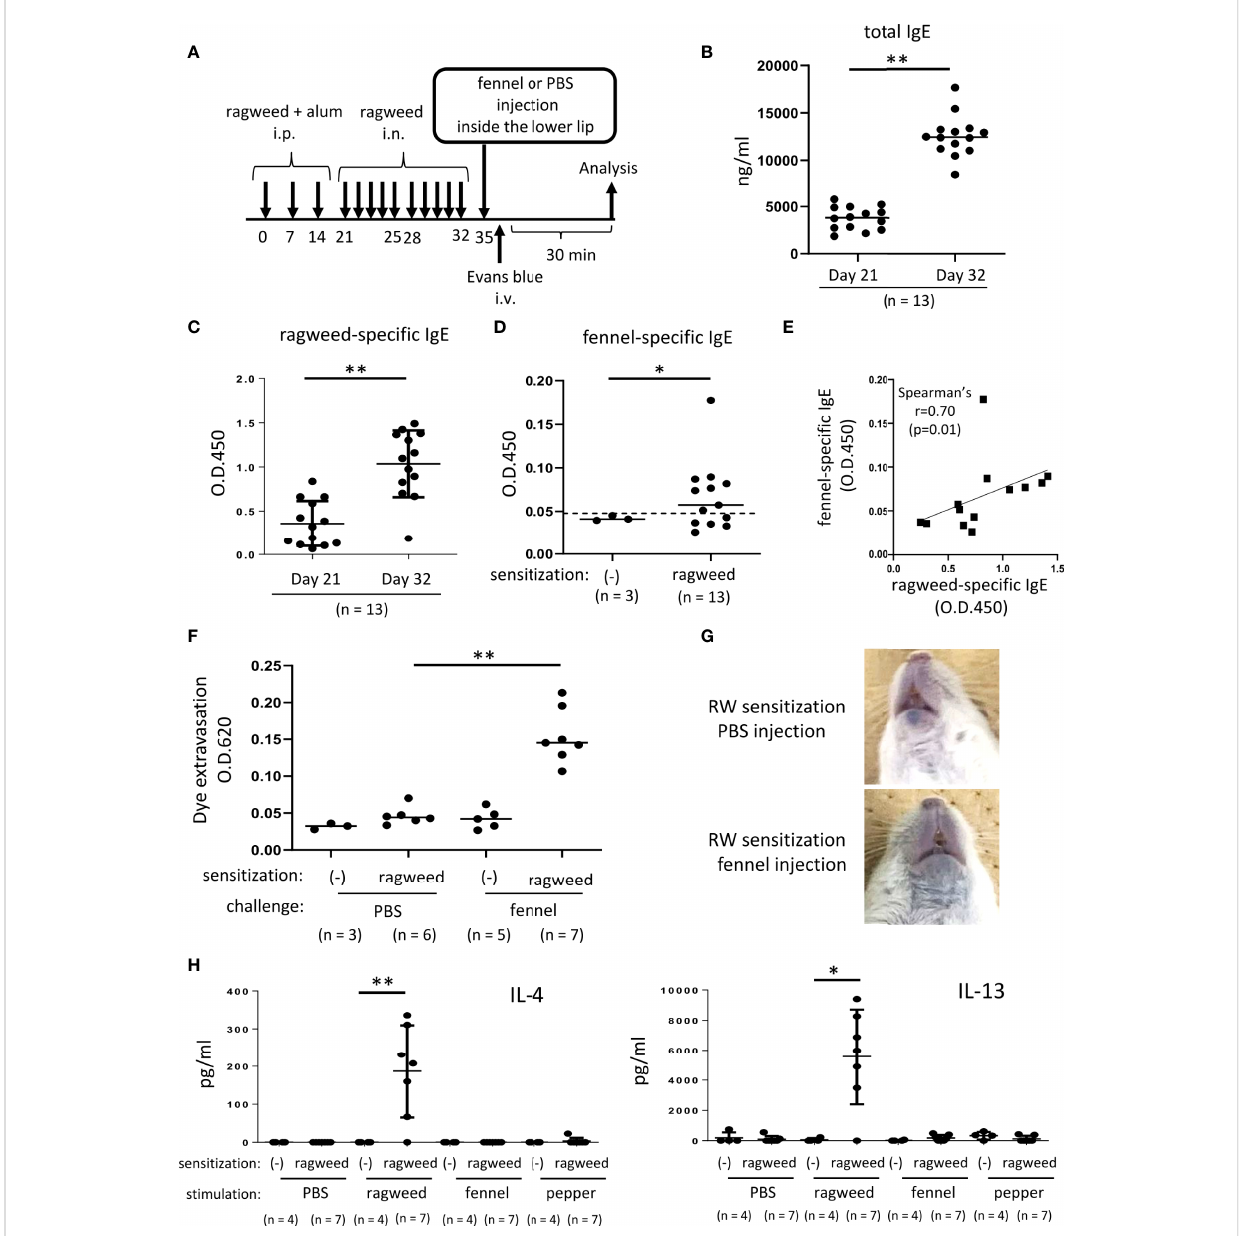
FIGURE 6 Stimulation with fennel extracts induced mast cell-dependent OAS in mice intraperitoneally and intranasally sensitized with ragweed pollen. (A) A schematic representation of murine model of OAS. WT mice intraperitoneally and intranasally sensitized with ragweed pollen before stimulation with fennel or PBS as a control. (B-D) Serum levels of total IgE (B) and ragweed-speci fi c IgE (C) from ragweed-sensitized mice (n = 13) at day 21 and at day 32. (D) Serum levels of fennel-speci fi c IgE from ragweed-sensitized mice (n = 13) at day 32 or from non-sensitized control mice (n = 3). A positivity threshold (mean + 2SD in non-sensitized mice) is shown as a dotted line. Data are expressed as mean ± SD. Data are representative of two independent experiments. Welch ’ s t -test. * P < 0.05; ** P < 0.01. (E) A weak positive correlation between serum levels of ragweed-speci fi c IgE and fennel-speci fi c IgE from ragweed-sensitized mice (n = 13). Spearman ’ s correlation test. (F) Quanti fi cation of the Evans blue dye that extravasated into the neck skin from ragweed-sensitized mice stimulated by fennel extract (n = 7) or PBS (n = 6) or from non-sensitized control mice stimulated by fennel extract (n = 5) or PBS (n = 3). Data are expressed as mean ± SD. Data are representative of two independent experiments. Brown-Forsythe and Welch ANOVA with Dunnett T3 multiple comparisons. ** P < 0.01. (G) Representative pictures of the neck skin from ragweed-sensitized mice stimulated by fennel extracts (lower panel) or PBS (upper panel). Data are representative of two independent experiments. (H) Levels of IL-4 (left) and IL-13 (right) in the culture supernatants from cervical LN cells from ragweed-sensitized mice (n = 7) or non-sensitized control mice (n = 4) in response to ragweed pollen, fennel, or black pepper extract. Data are expressed as mean ± SD. Data are representative of two independent experiments. Brown-Forsythe and Welch ANOVA with Dunnett T3 multiple comparisons. * P < 0.05; ** P <